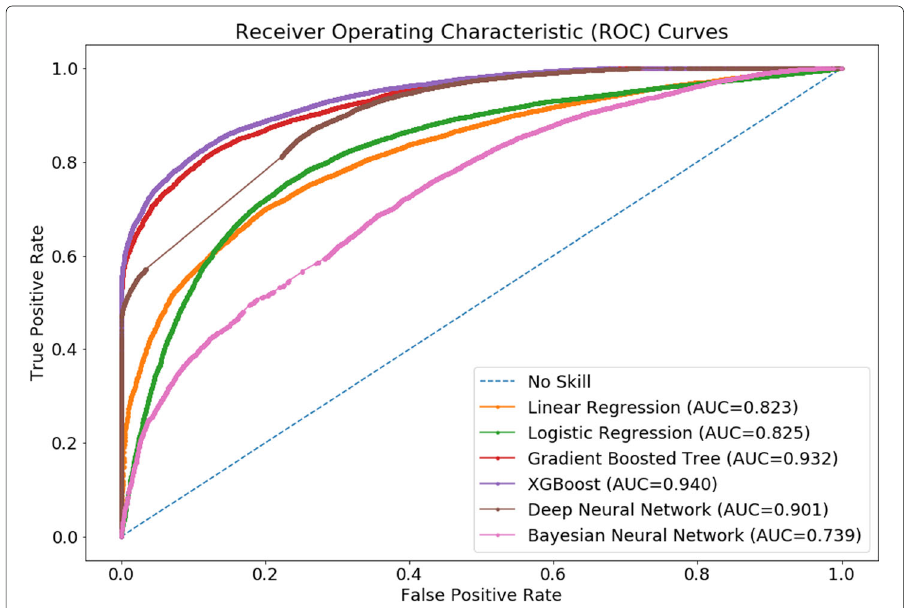
Fig. 3 ROC curves for machine learning